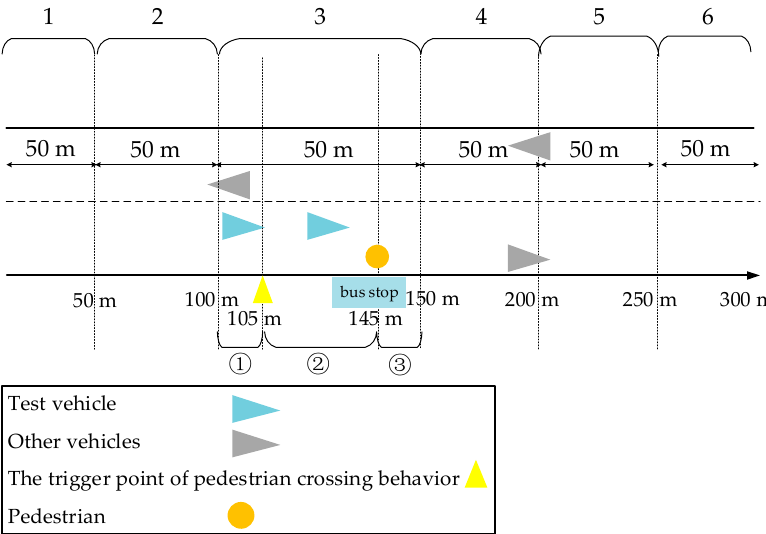
Figure 7. The segments of the risky scenarios. Table 4. Description of each segment in risk scenarios.